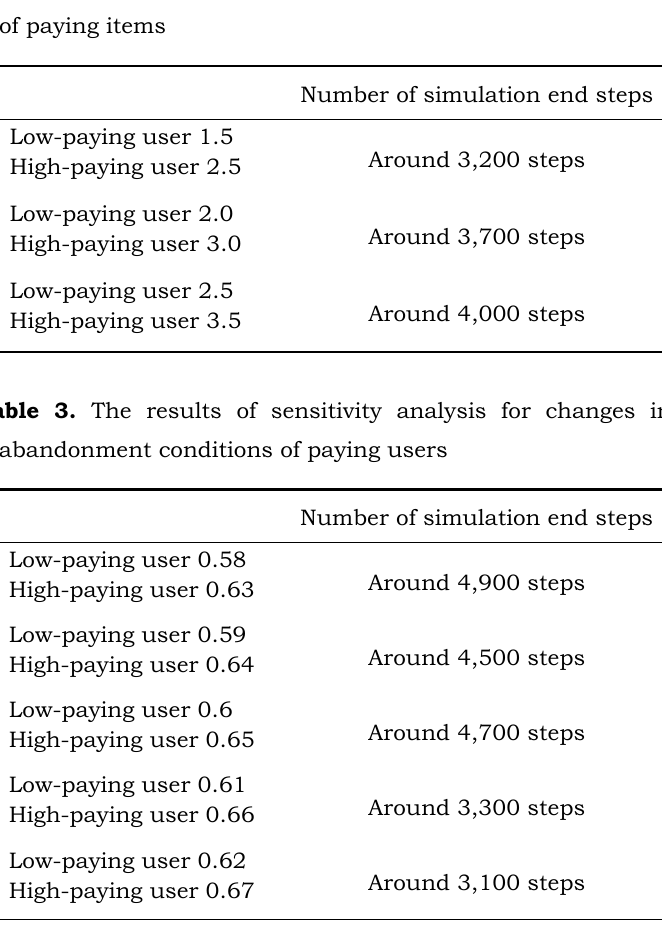
Table 2. The results of sensitivity analysis for changes in effect